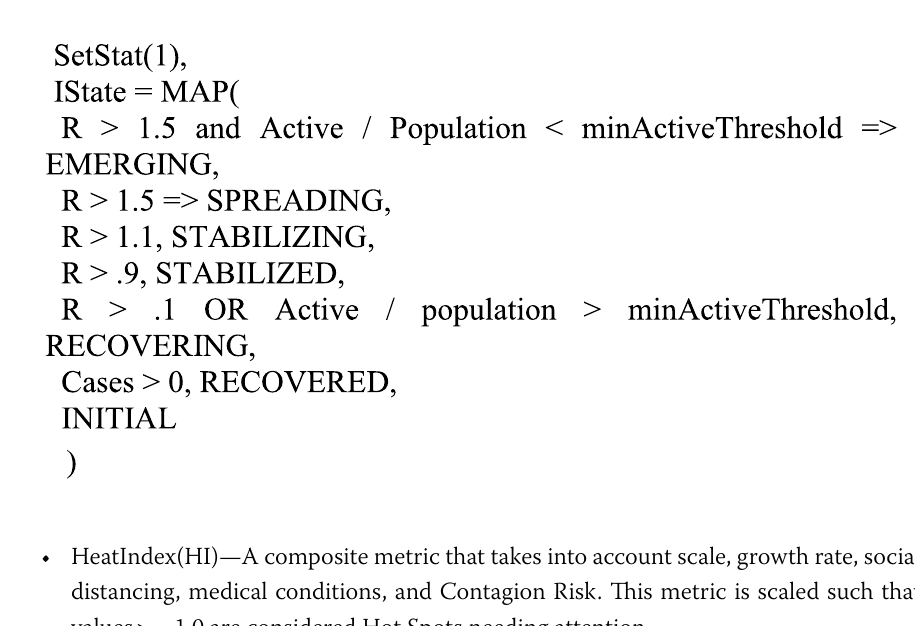
Indicators are zero-based, with negative numbers indicating negative outcomes, and positive numbers positive